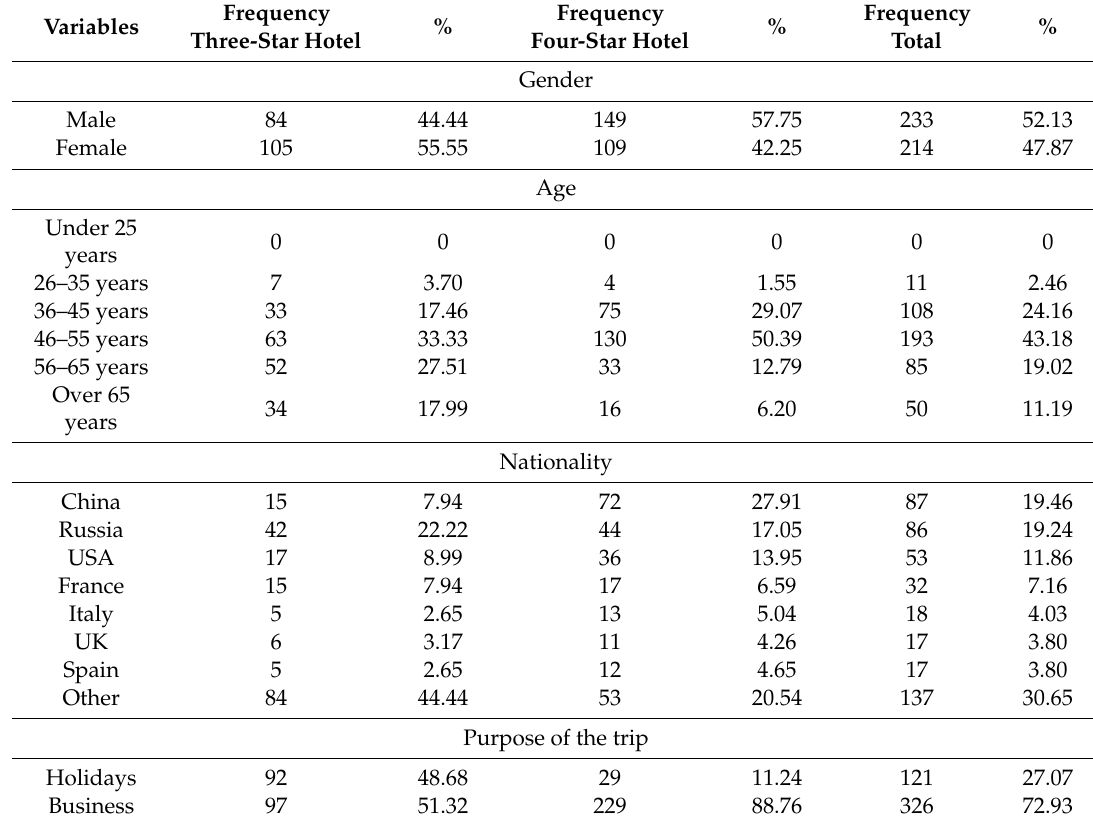
Table 1. Guests’ profile (source: compiled by